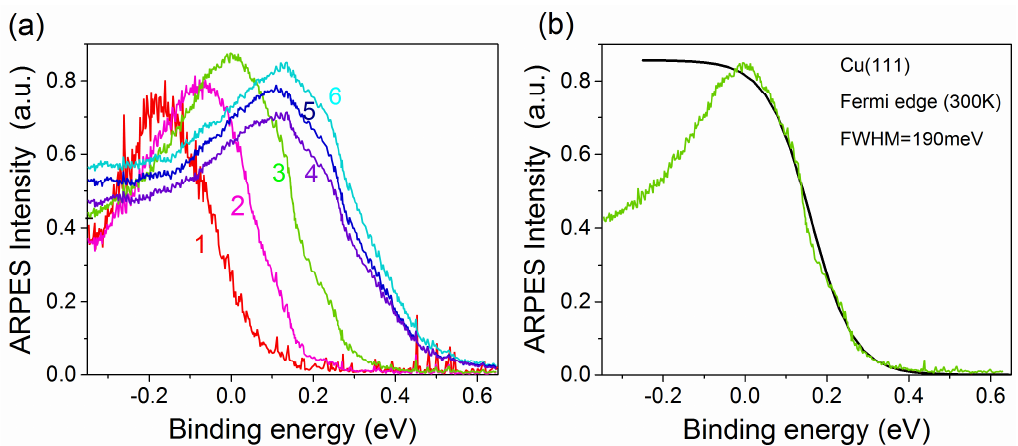
Figure 11. ARPES spectra of the Fermi edge of Cu (111) as a function of incident EUV flux on the sample material. EUV photon energy H13 (20.15 eV); monochromator grating G2 and slit width = 100 µ m. ( a ) spectra measured with the following EUV photon fluxes (ph/s): (1) 6 × 10 8 ; (2) 1.5 × 10 9 ;